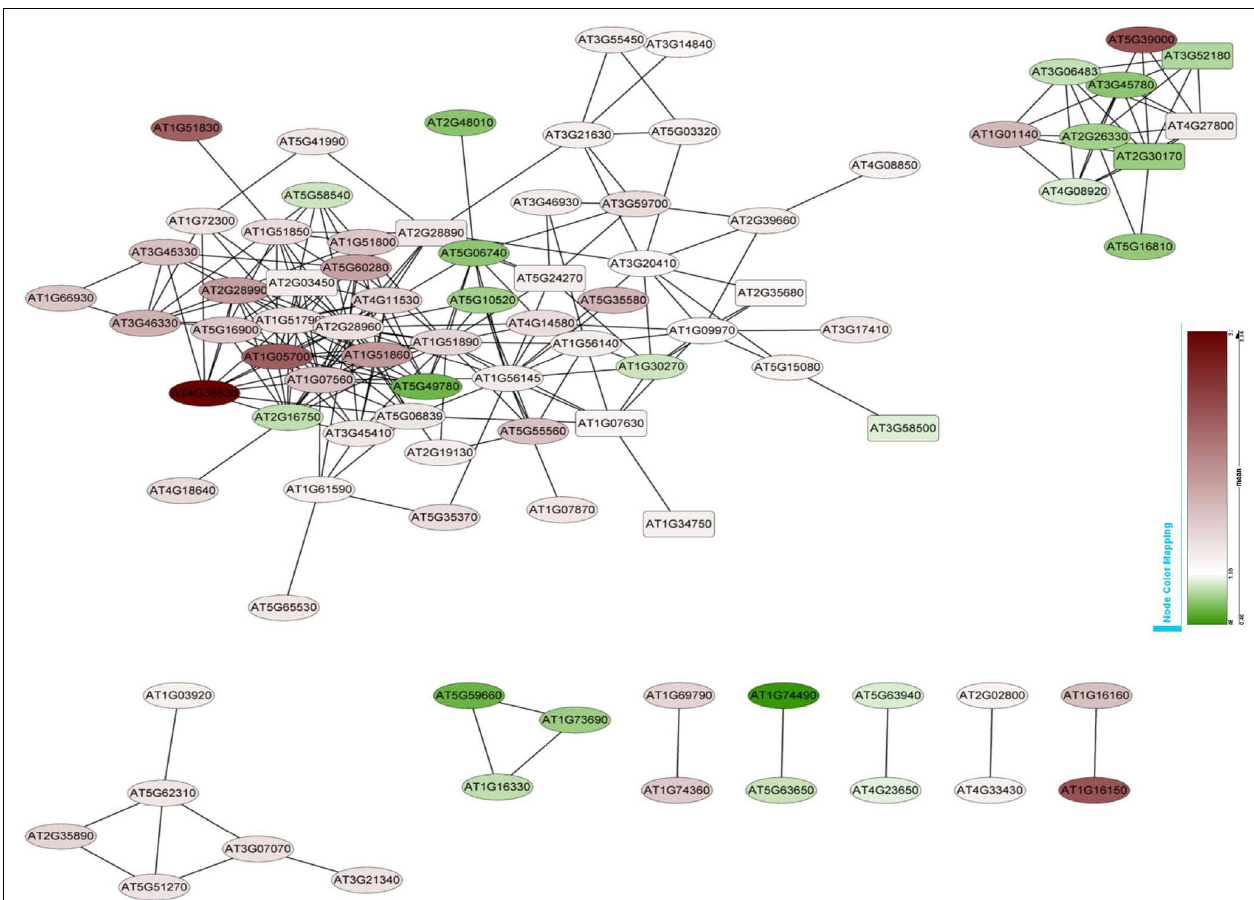
FIGURE 3 | Co-expression relationships of the differentially expressed PK and PP genes . Red nodes indicate up-regulated genes, green nodes denote genes that are repressed by Fe deficiency. Round-shaped nodes represent protein kinase genes, rectangles indicate protein phosphatase